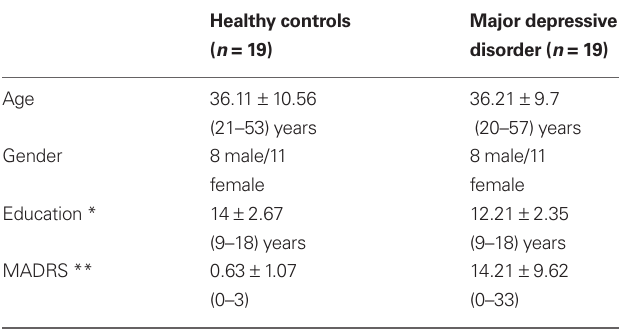
Table 1 | Demographic and clinical characteristics for the study